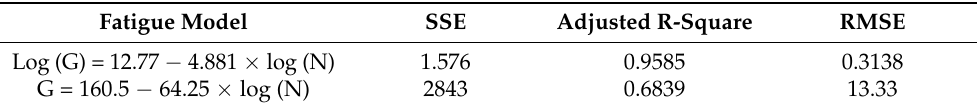
Table 4. Calibrating different fatigue